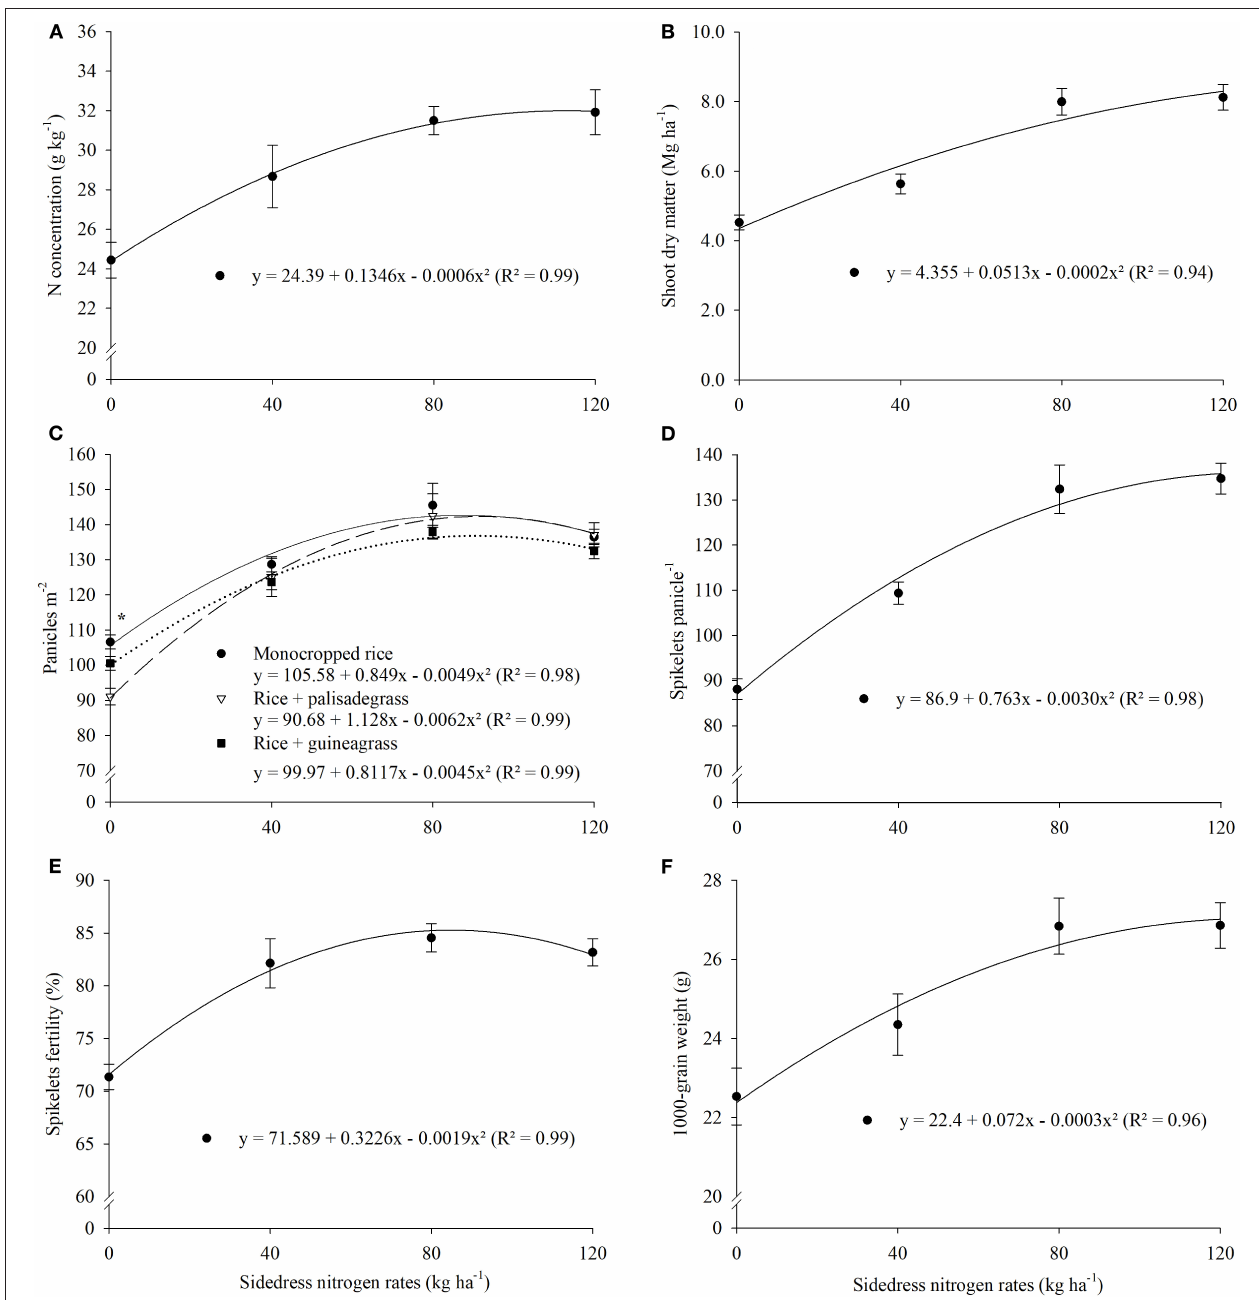
FIGURE 1 | Rice leaf nitrogen concentration (A) , shoot dry matter (B) , cropping system × sidedress nitrogen rates interaction effect on panicles m − 2 (C) , spikelets panicle − 1 (D) , spikelets fertility (E) , and 1,000-grain weight (F) as affected by sidedress nitrogen rate. Each data point is the mean of 36 replicates (three cropping systems, four blocks, and three growing seasons) and associated error bar is ± one SE. * P ≤ 0.05.